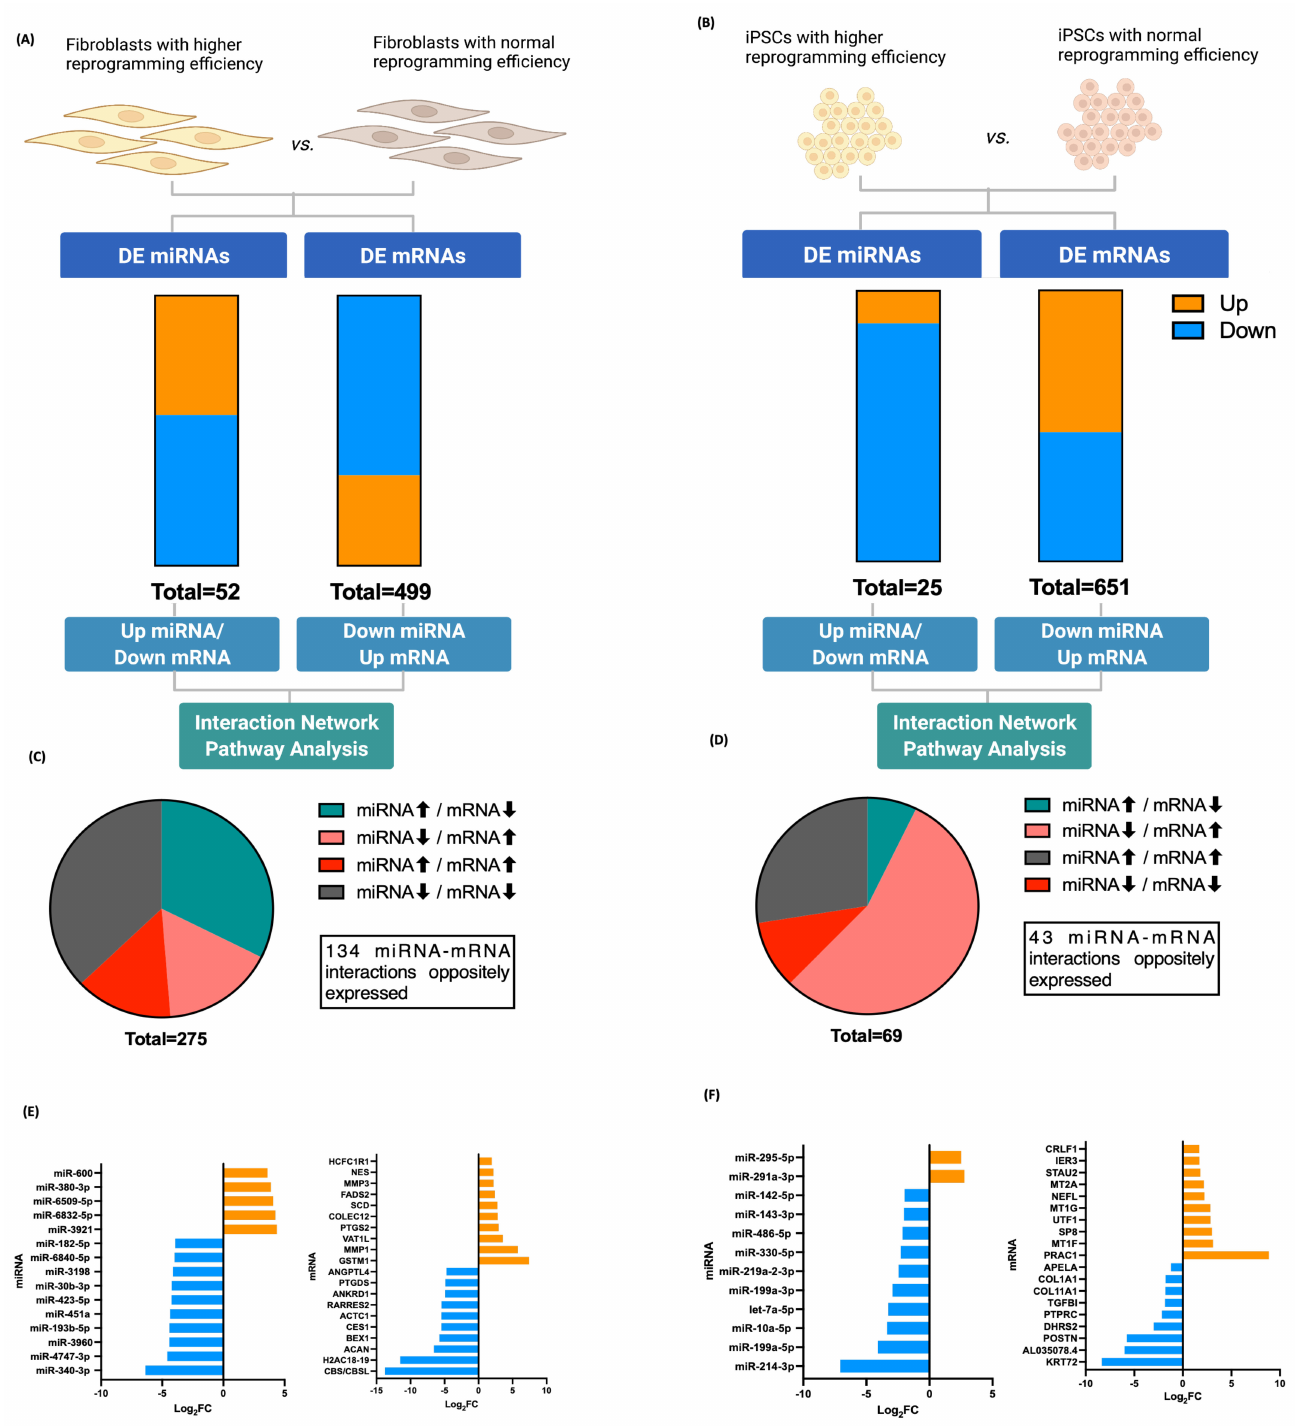
Figure 3. The differentially expressed miRNA and proportion estimates of DE miRNome and DE transcriptome in fibroblasts and iPSCs with high reprogramming efficiency. ( A ) A bar graph of significantly the number of down- and up-regulated miRNAs and mRNAs in fibroblasts. ( B ) A bar graph of significantly the number of down- and up-regulated miRNAs and mRNA in iPSCs. ( C ) A pie chart of miRNA-mRNA interactions in fibroblasts. ( D ) A pie chart of miRNA-mRNA interactions in iPSCs. ( E ) Top down- and up-regulated miRNAs and mRNAs in fibroblasts. ( F ) Top down- and up-regulated miRNAs and mRNAs in